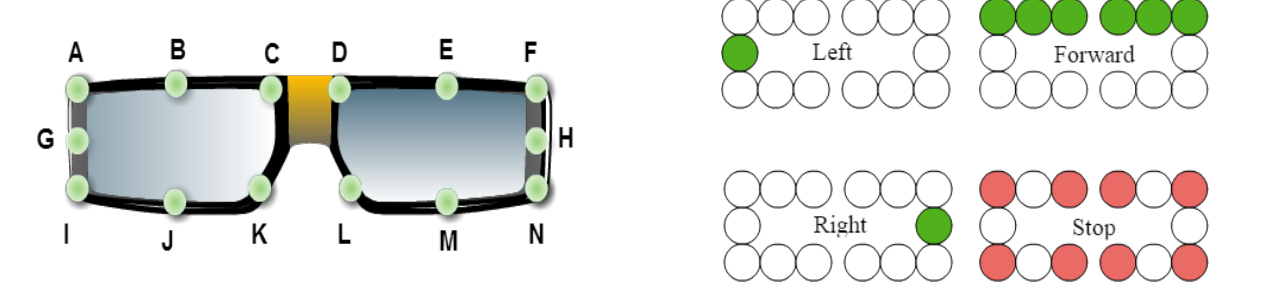
Figure 3. Assigning specific symbols to each indicator to measure visibility of them while conducting the Bayesian analysis.